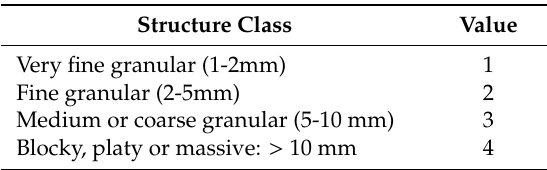
Table 2. Classes of soil structure